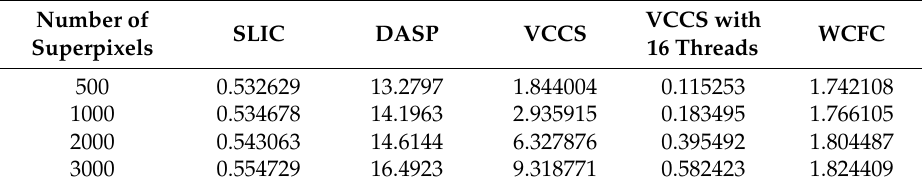
Table 1. The runtime of superpixel